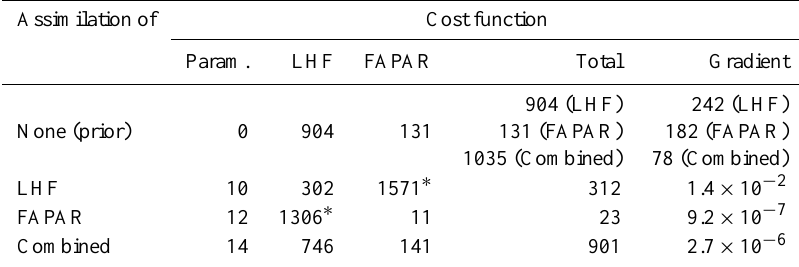
Table 2. Cost function contributions from parameters (Param.), latent heat flux (LHF), and fraction of absorbed photosynthetically active radiation (FAPAR), as well as the total cost function value and the norm of the gradient. Assimilation